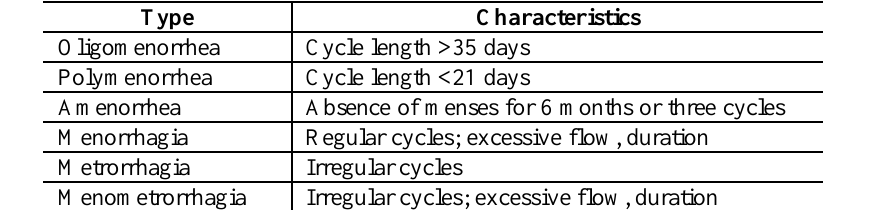
Table II : Types and characteristics of abnormal uterine bleeding (Compiled from Petrozza and Poley 19 and Speroff et al. 21 )